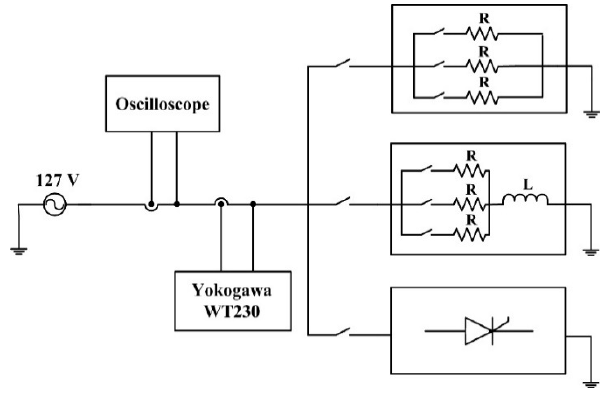
Figure 1. Experimental arrangement.